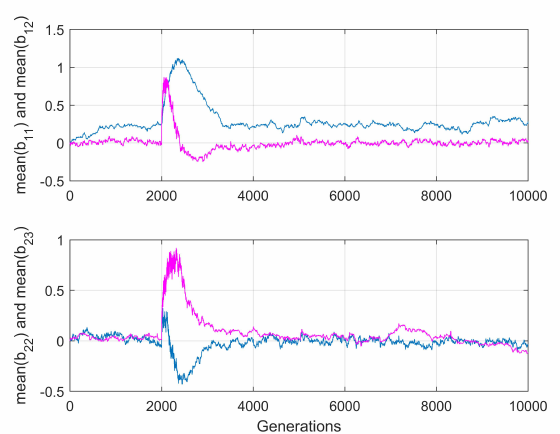
Figure 9: Mean plasticity slopes as function of time (generations) corresponding to the step re- sponse phase plots in Figure 8. Upper panel shows ¯ b 11 (blue) and ¯ b 12 (magenta), and lower panel shows ¯ b 22 (blue) and ¯ b 23 (ma- genta). All initial parameter values were set to